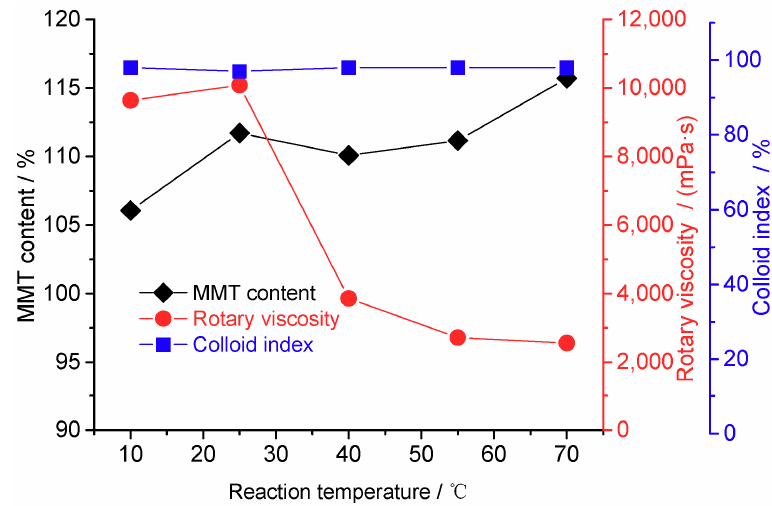
Figure 3. Properties of the montmorillonite (MMT) as a function of the reaction temperature (reaction conditions: sodium carbonate mass = 2.8%, 2 h, and stirring speed = 300 rev/min).